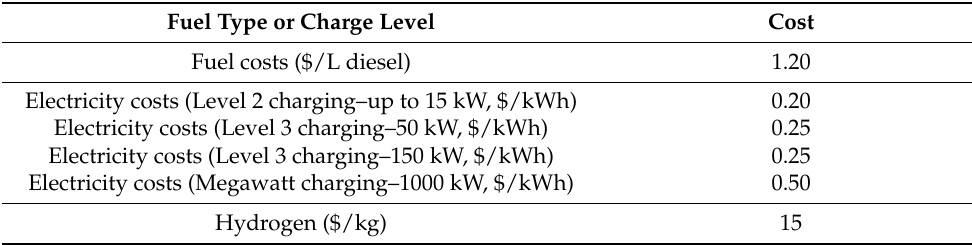
Table 4. Fuel costs and electricity